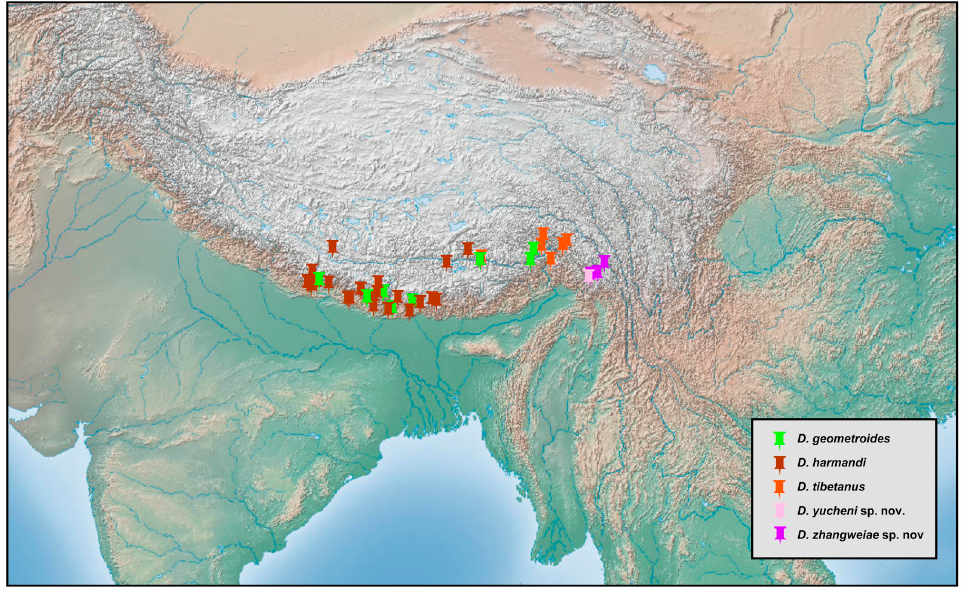
Figure 23. Distribution map of the species of Dilar from southern Tibet and adjacent area (Region 4 in Figure 19).